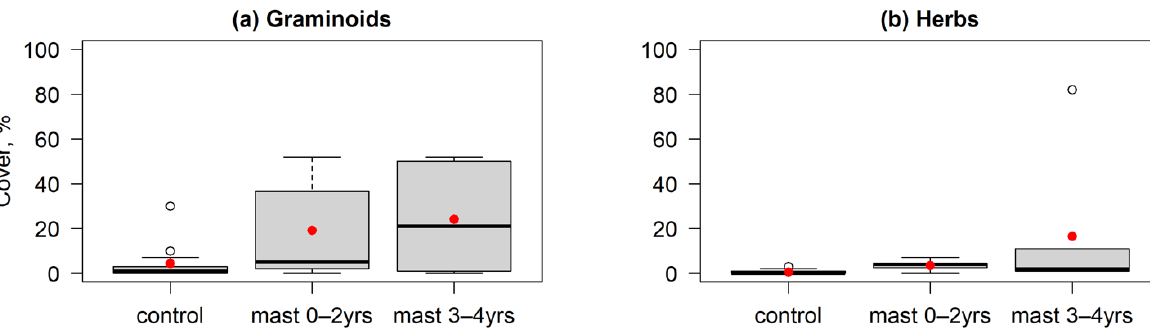
Figure 7. Floristic diversity metrics for ( a ) species richness; ( b ) species richness excluding exotic species; ( c ) Shannon’s H’ and; ( d ) Shannon’s H’ excluding exotic species for 0–2 years since mastication, 3–4 years since mastication and control.